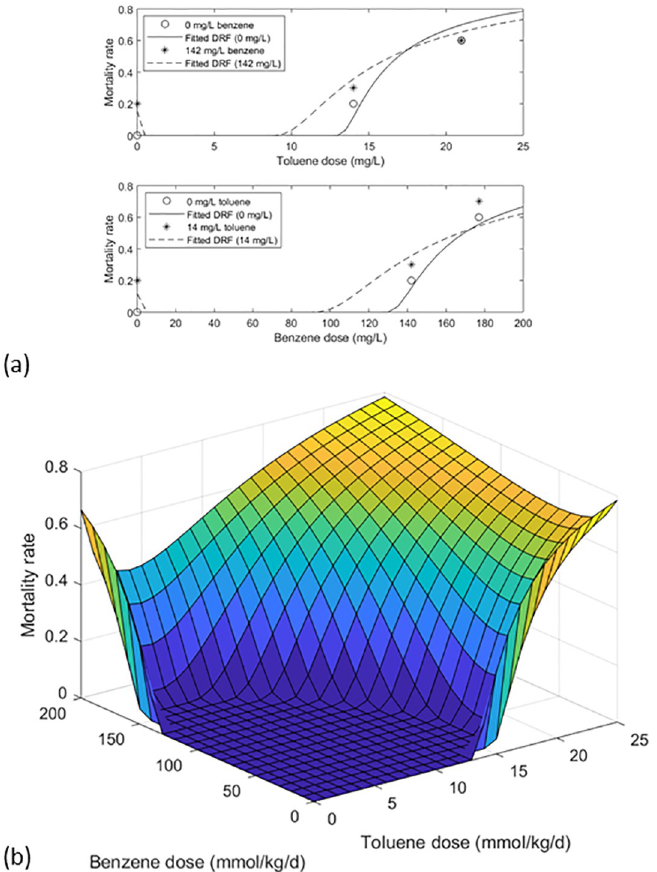
Fig 6. First-order common mode DRF fitted to data on medaka mortality following 96 hours of embryonic exposure to benzene/toluene mixtures. (a) mortality versus toluene dose, with and without 142 mmol/kg/d benzene, and mortality versus benzene dose, with and without 14 mmol/kg/d toluene; and (b) fitted DRF, showing suggested antagonism.